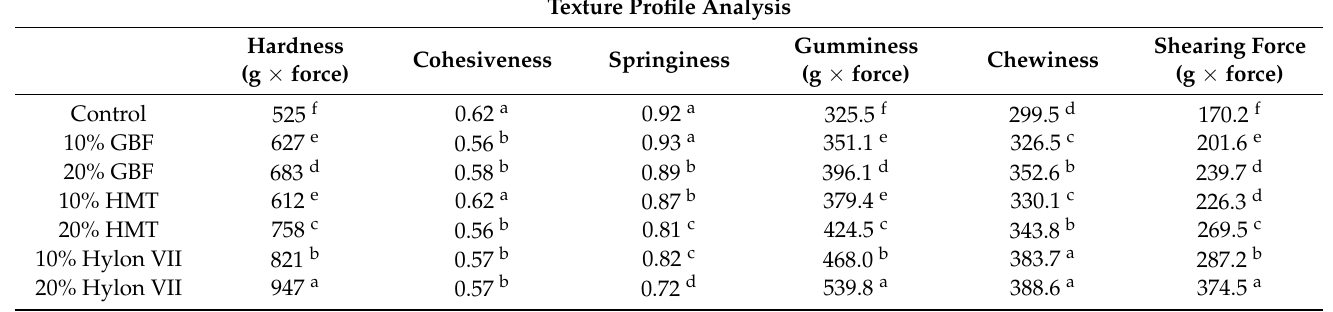
Table 4. Texture profiles of cooked salted noodles containing different proportions of resistant starch source flour. Texture Profile Analysis